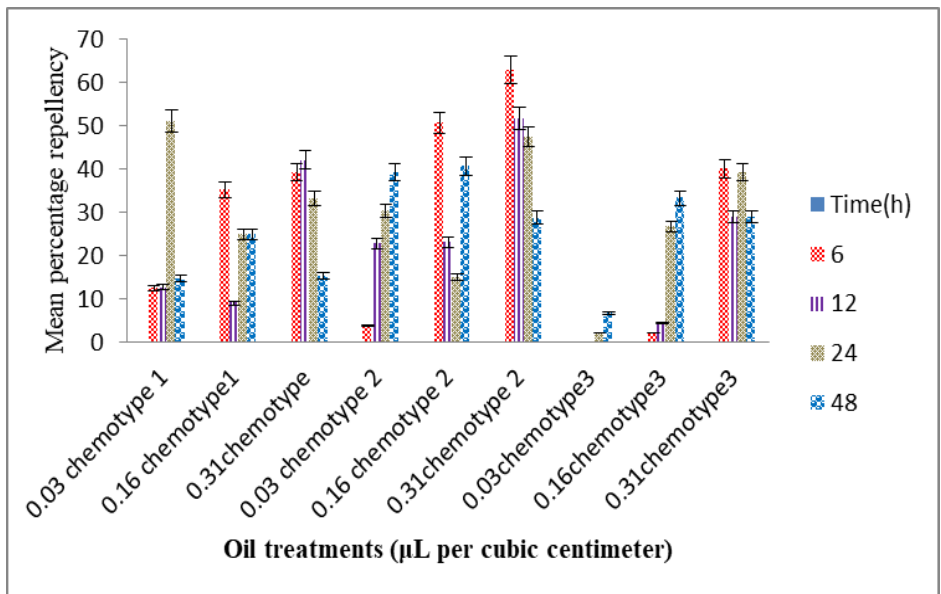
Figure 6. Mean percentage repellence of three varieties of T. vogelii against S. zeamais .